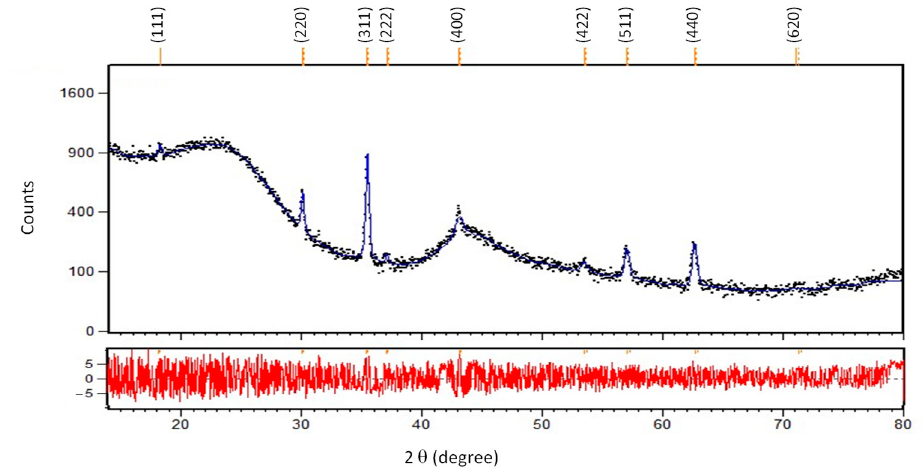
Figure 4. XRD diffractogram of dip coated RVC. The observed (black dots), calculated (blue line), and difference between fitted and observed patterns (red line) are shown. Bragg positions of the Fd-3m: 227 space group are included.